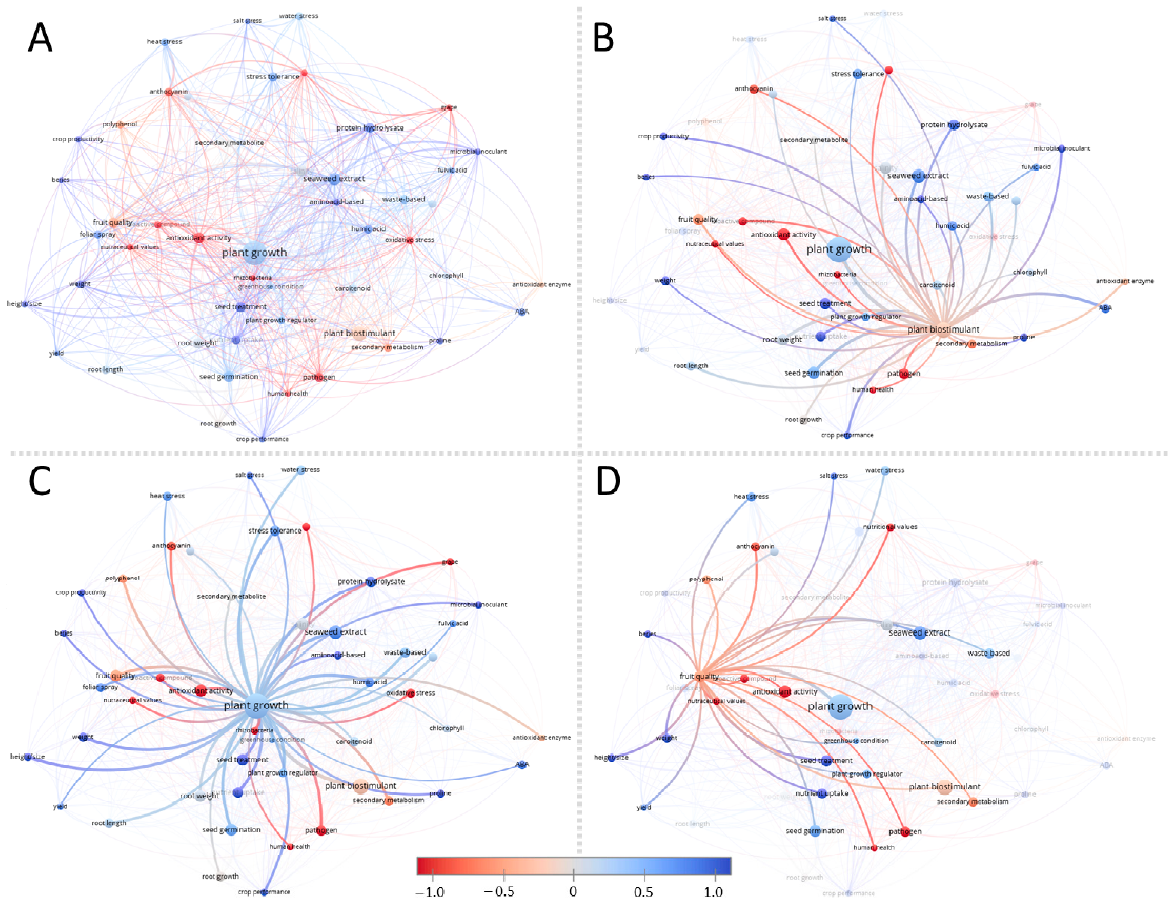
Figure 5. Visual cluster analysis generated using papers published during the last 5 years and related to biostimulant products. The plot was generated by using VOSviewer software (ver. 1.6.15) [217,218]. Panel ( A ) reports the general plot; Panel ( B ) highlights the connections between the terms “Plant Biostimulant” and other terms; panel ( C ) highlights the connections between the terms “Plant Growth” and other terms; panel ( D ) highlights the connections between the terms “Fruit Quality” and other terms. For each panel, the bubble map visualizes the 50 most frequent terms that appeared in the papers published in the last 5 years ( n = 856). Bubble size indicates the frequency of occurrence of the words; the color indicates the association strength (from − 1 to +1); the lines between bubbles represent the linkage among terms.